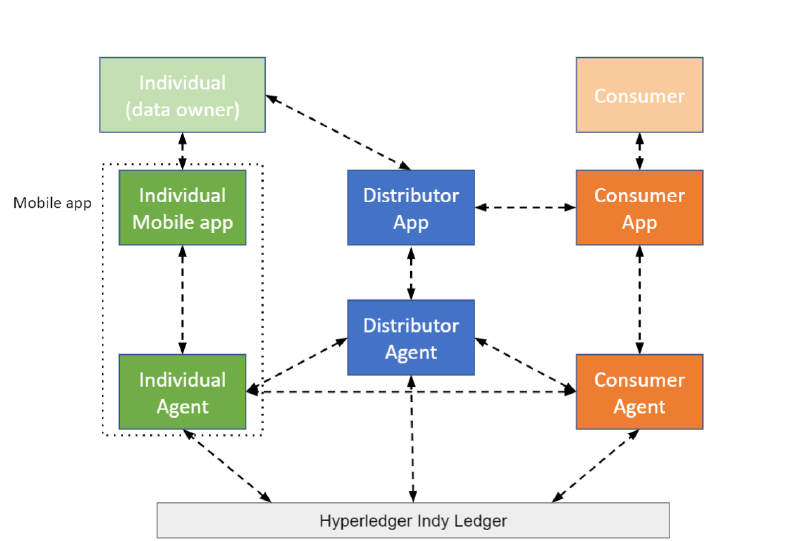
Fig. 8. Licensing